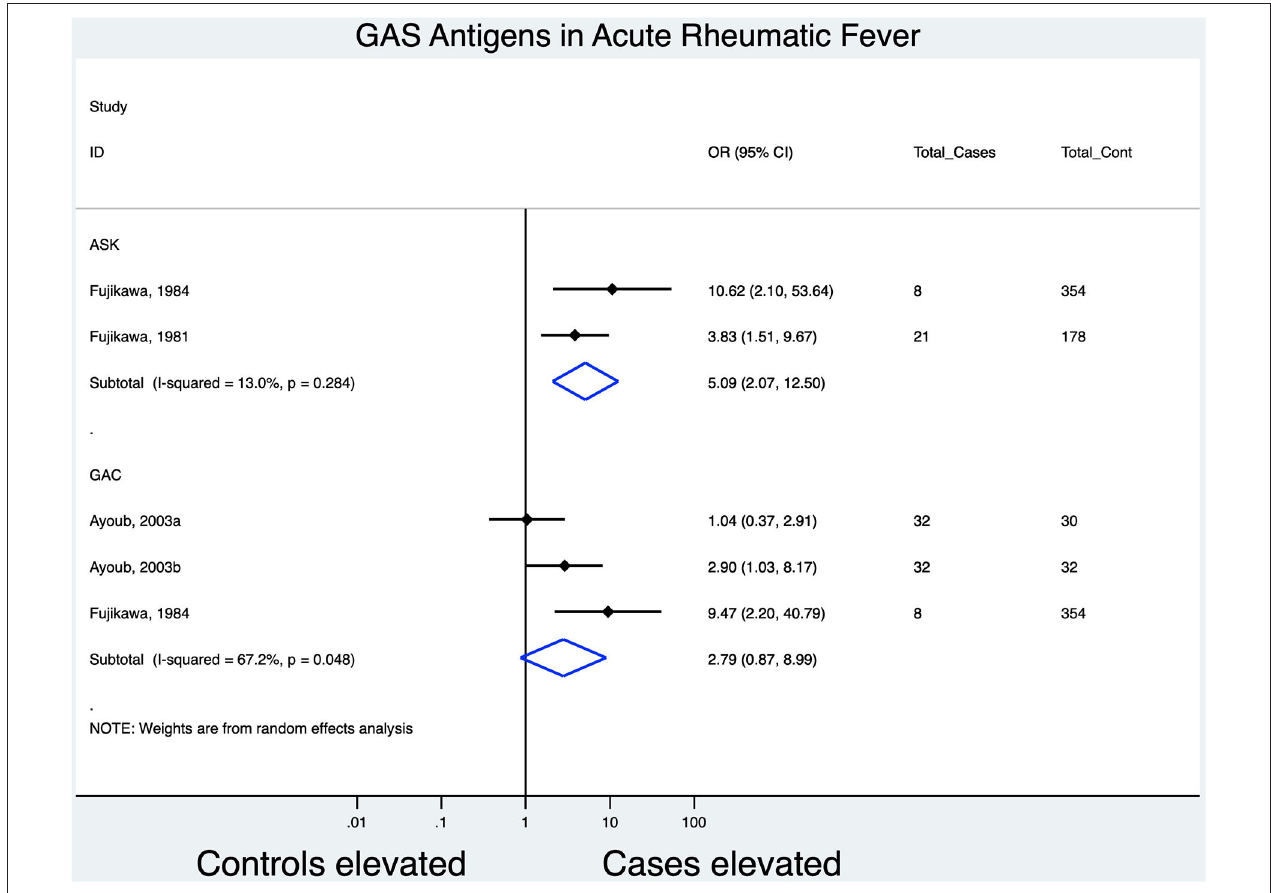
FIGURE 4 | Forest plot evaluating the odds of association between anti-ASK and anti-GAC titers and ARF; subgrouping based on